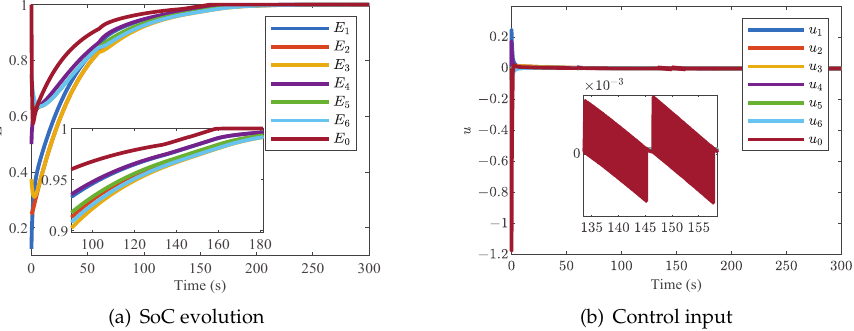
Figure 14. Simulation results under communication graph change with a WE-based smart leader in Case